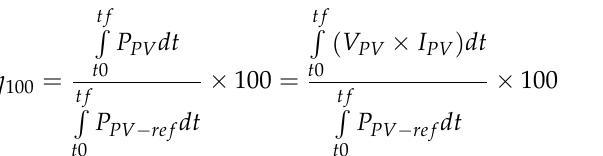
Figure 5. PV ( a ) maximum power point (MPP) power ( b ) MPPT error with all controllers. IC: